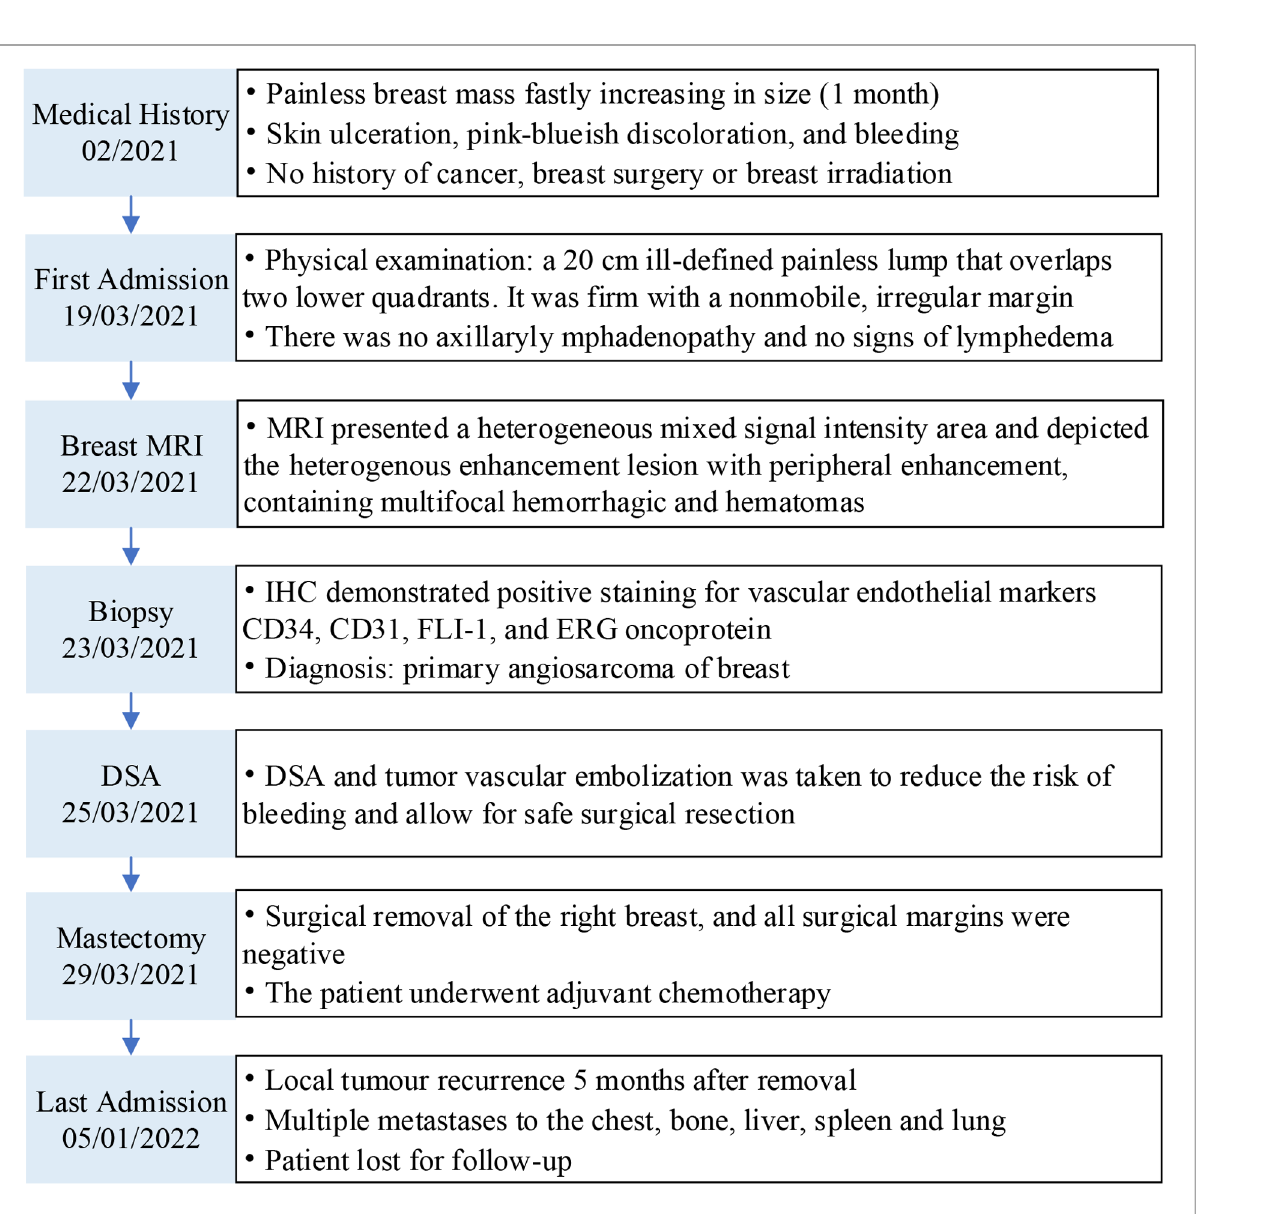
FIGURE 1 Case report timeline. MRI, magnetic resonance imaging; DSA, digital subtraction angiography; IHC,